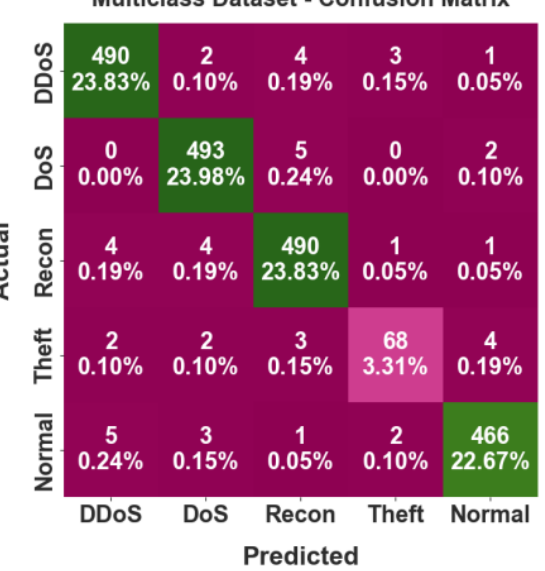
Figure 7. Confusion matrix of the H3SC-DLIDS approach on multiclass dataset.